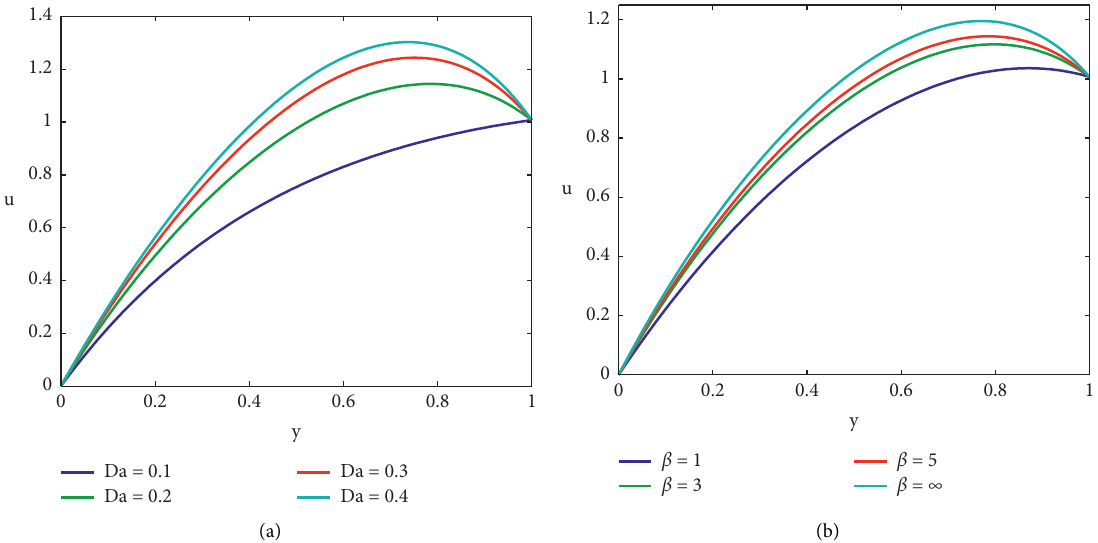
Figure 4: (a) Effect of Da on the “velocity distribution” when β � 5. (b) Effect of β on the “velocity distribution” when Da � 0 .